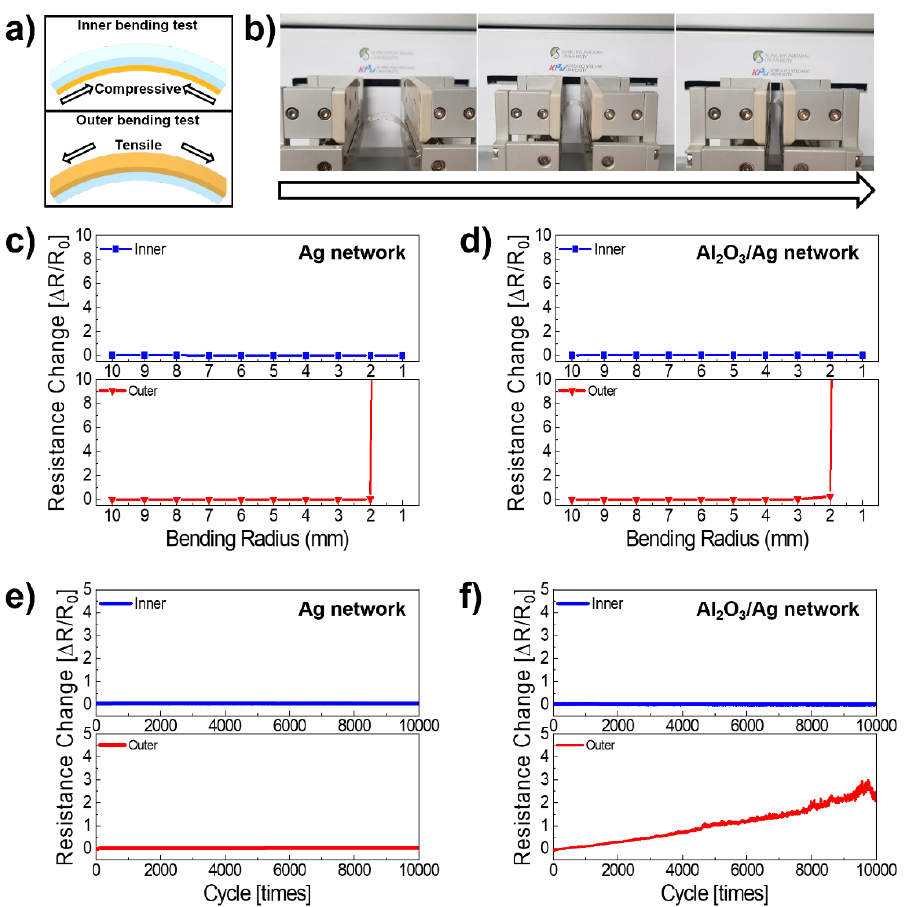
Figure 3. ( a ) Effect of bending on the film and substrate. ( b ) Bending test procedure. ( c ) Results of critical inner/outer bending test of the Ag network electrode. ( d ) Results of critical inner/outer bending test of the Al 2 O 3 /Ag network electrode. ( e ) Results of repeated inner/outer bending test of the Ag network electrode. ( f ) Results of repeated inner/outer bending test of the Al 2 O 3 /Ag network electrode.